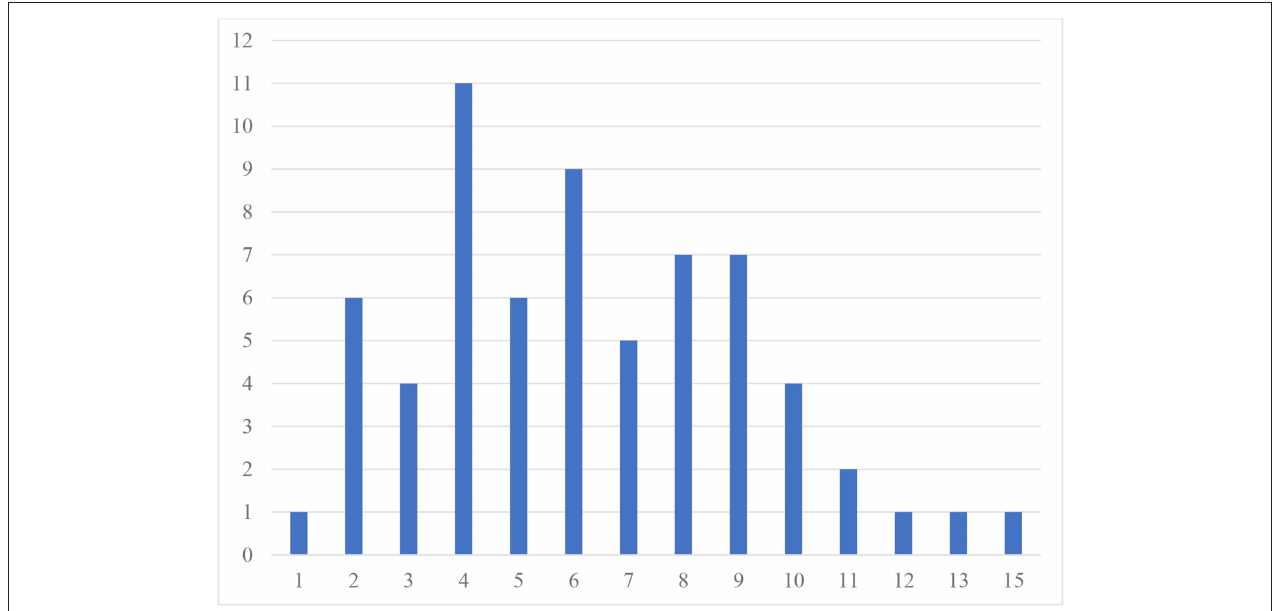
FIGURE 1 | Frequency of participants by number of CASI − 5 symptom classifications with clinically significant ratings. Number of psychiatric comorbidities exceeding clinical cutoff